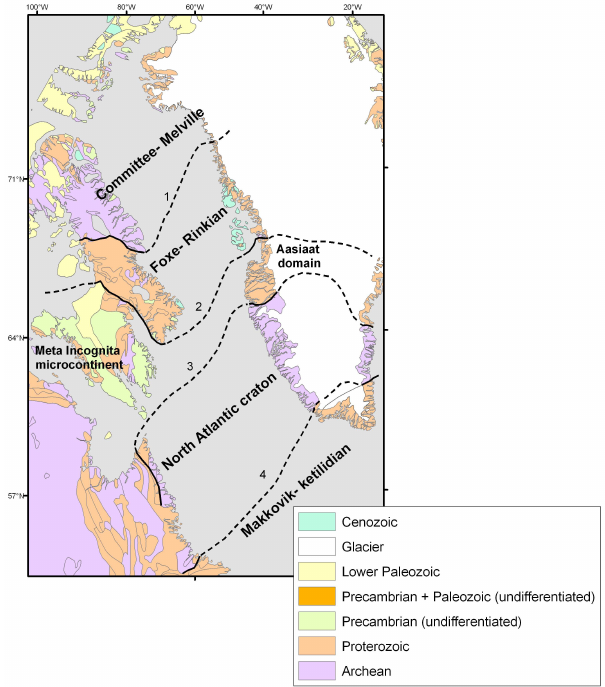
(Bouysse, 2010) used for lateral correlation of two margins. We use sedimentary formations and rock units older than Palaeozoic to cor- relate the full-fit alignment of the conjugate margins. Numbers refer to structural features separating those units and formations that have been mentioned and discussed in more detail in the main